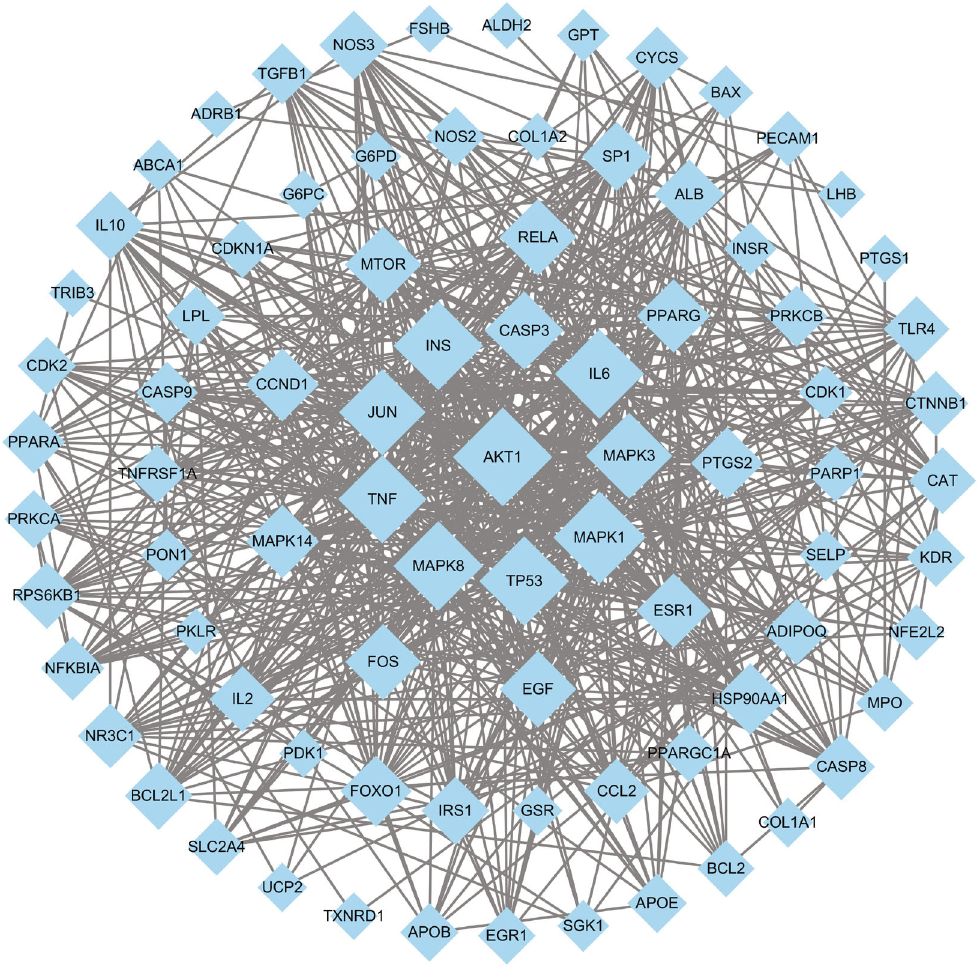
Figure 3: Target-diabetic nephropathy protein-protein interaction (PPI) network. AKT1, MAPK8, TP53, INS, MAPK1, IL6, TNF, JUN, MAPK3, and CASP3 were the targets with higher degree ( >